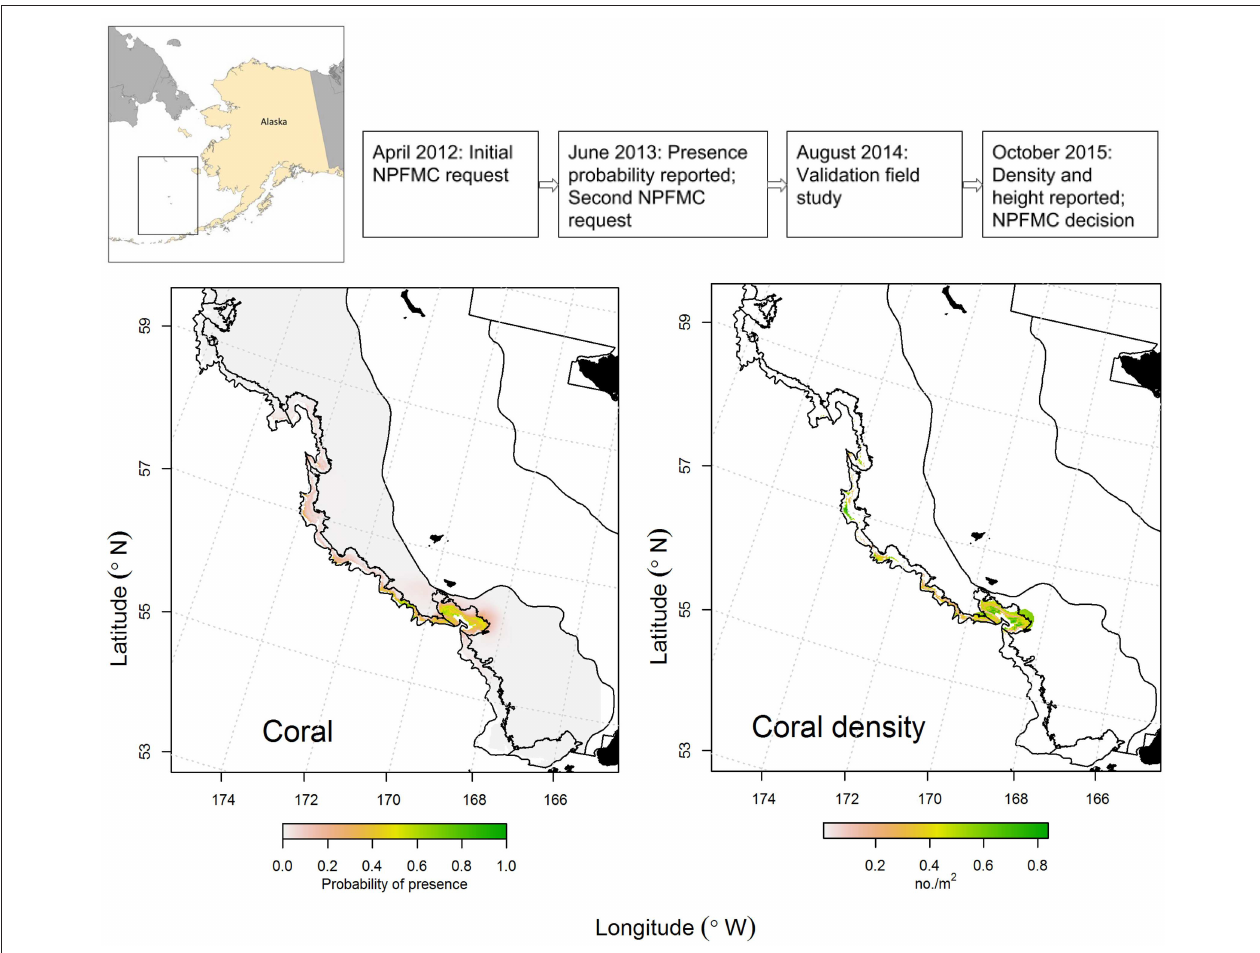
FIGURE 3 | Case Study 1: Eastern Bering Sea Coral Canyons. Timeline (top): Chronology of North Pacific Fishery Management Council (NPFMC) requests, reports, and decision. Plots of predicted presence of coral (adapted from Sigler et al., 2015, left) and predicted density of coral (adapted from Rooper et al., 2016, right). Predicted presence (left) was reported in June 2013 and was based on presence-absence data collected during ecosystem-scale bottom trawl surveys. Predicted density (right) was reported in October 2015 and was based on density data collected during an ecosystem-scale underwater stereo camera survey (the validation study) that was used to update the predicted presence model. Black areas indicate land, and black lines represent boundaries between inner, middle, and outer shelf and slope areas ( Sigler et al.,